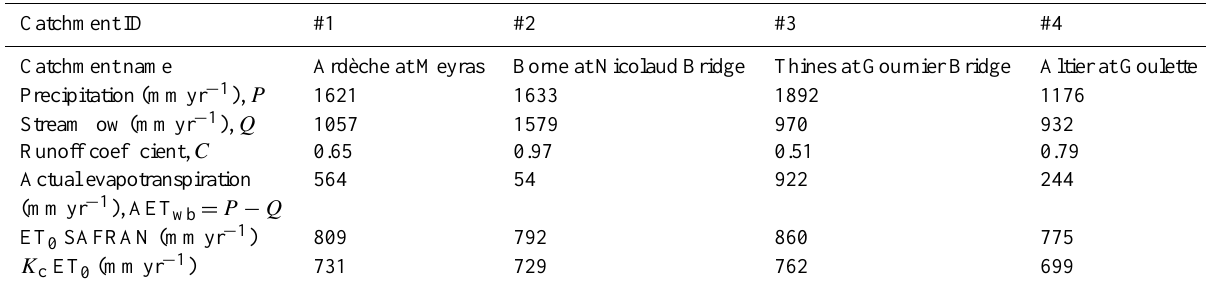
Table 3. Hydro-climatic characteristics of the four examined Ardèche sub-catchments (2000–2008). Catchment ID #1 #2 Ardèche at Meyras Borne at Nicolaud Bridge Thines at Gournier